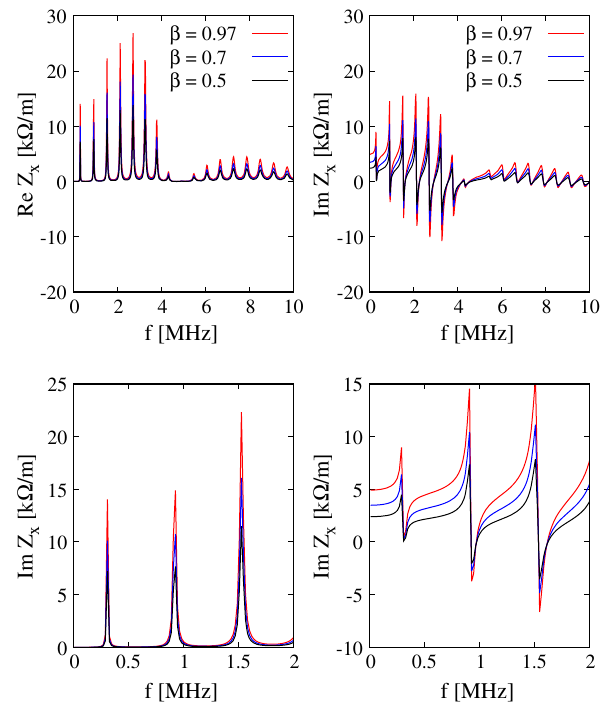
FIG. 3. Real (left) and imaginary (right) parts of theoretically given transverse impedances of a KM in the RCS [5]. The left and right plots show the real and the imaginary parts of the impedance, respectively. The impedance of a relativistic beam is seen to be much higher than that of a nonrelativistic beam. The expanded view of the impedances at the lower frequency region are shown in the lower